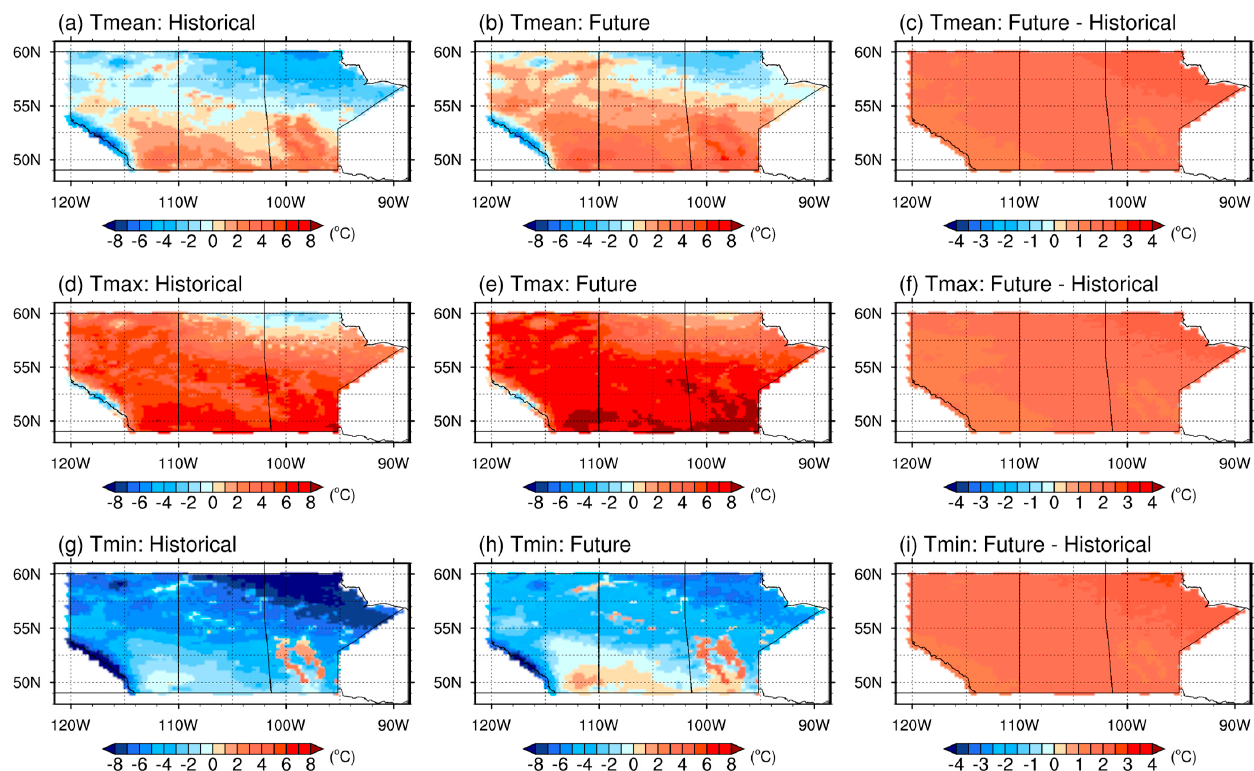
Figure 4. Projected variations of annual averages of T mean , T max , and T min for the period of 2066 to 2095 under RCP45. ( a , d , g ) show the historical distributions of T mean , T max , and T min , respectively; ( b , e , h ) show the future distributions of T mean , T max , and T min , respectively; ( c , f , i ) show the projected variations of V mean , V max , and V min , respectively.